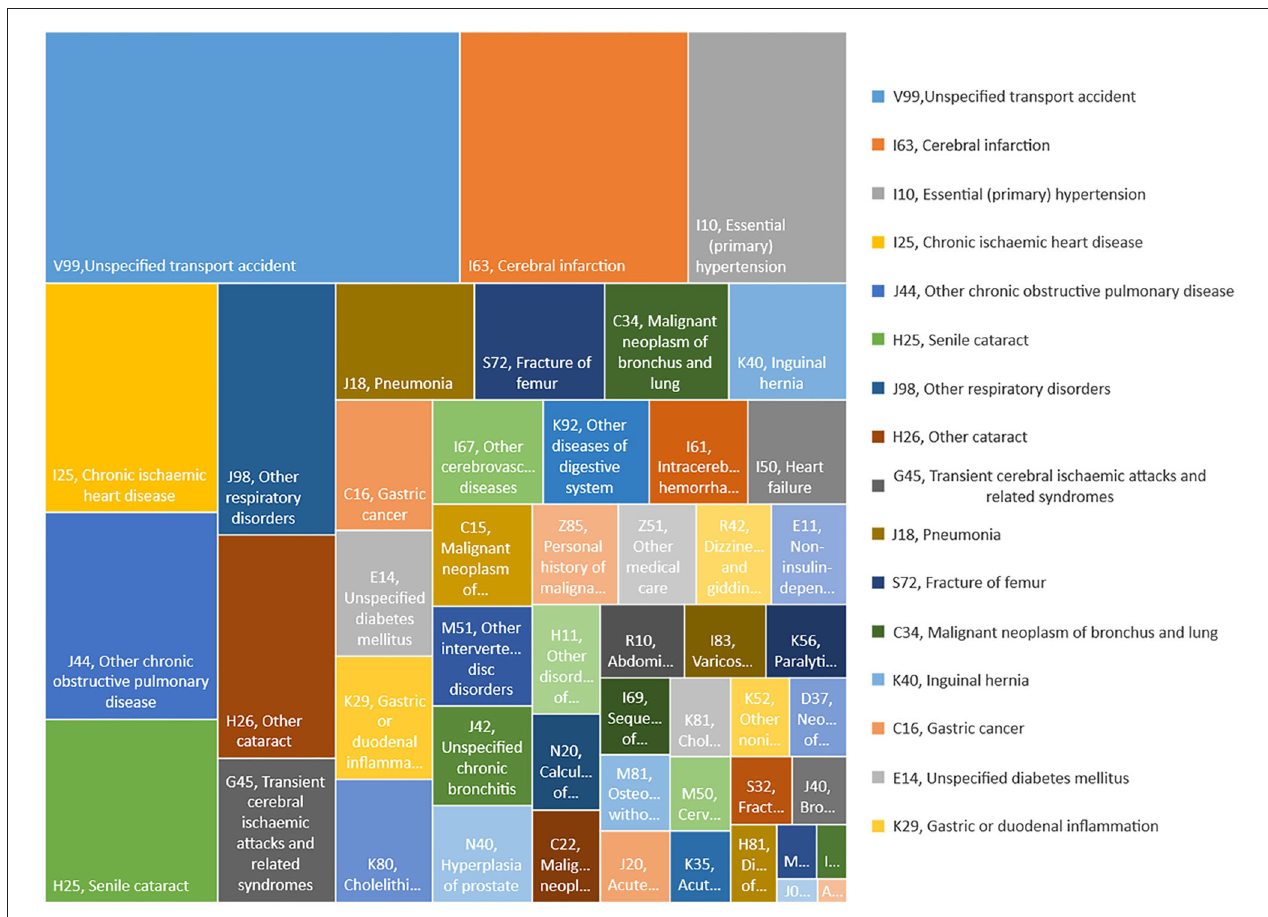
FIGURE 2 | The proportion of rural elderly inpatients with CHE by discharge diagnoses from 2010 to